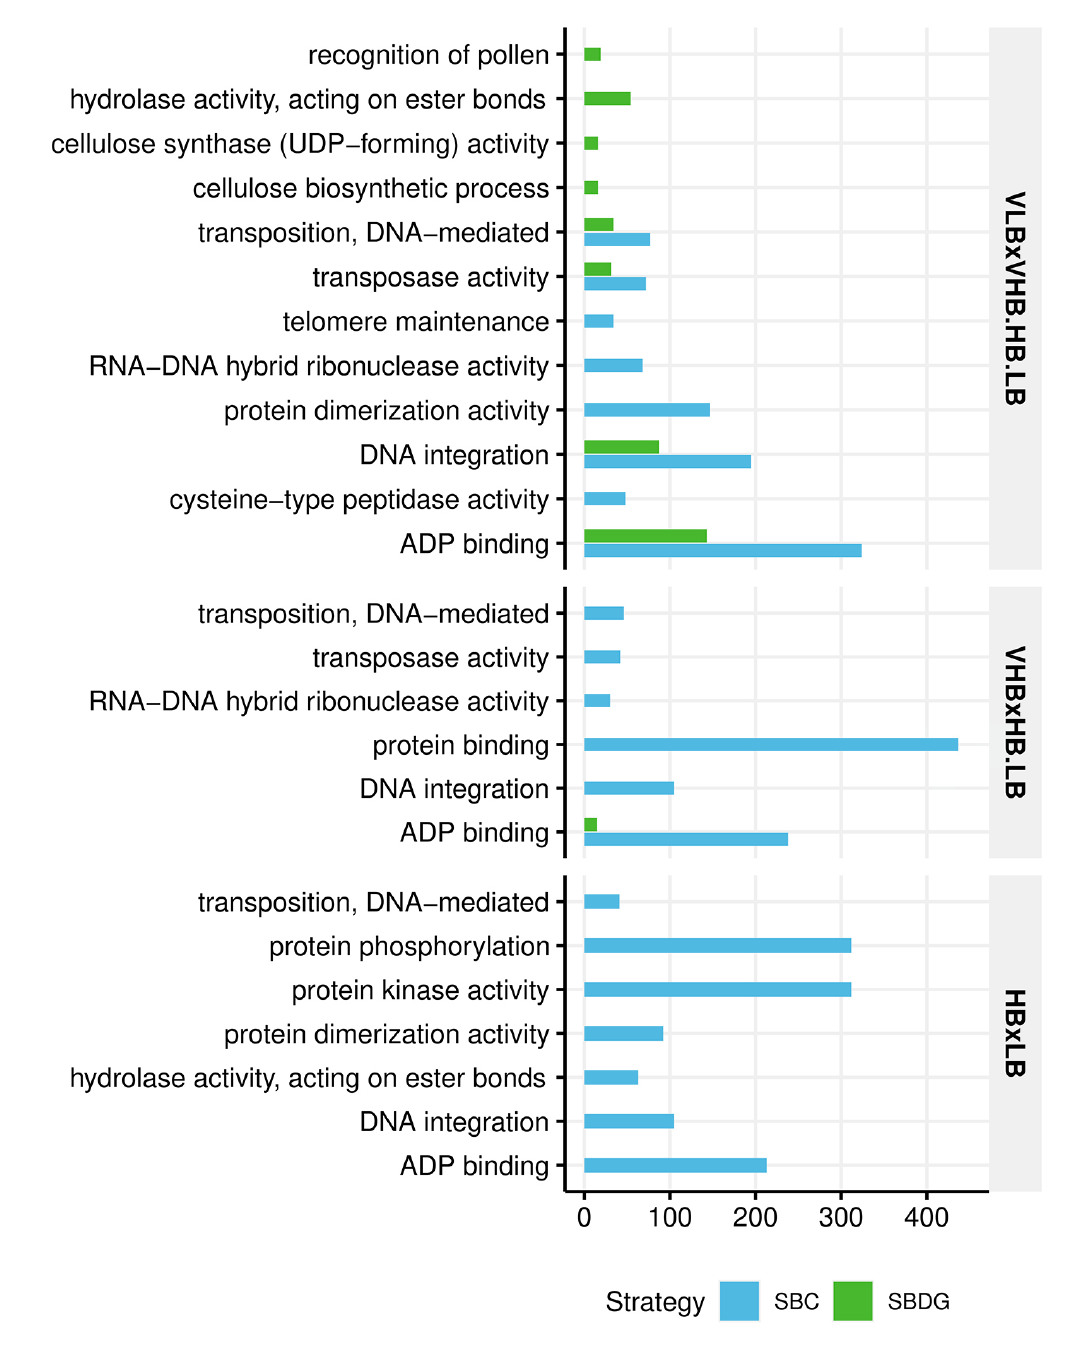
Figure 2 – Enriched gene ontology terms by strategy and contrast. There was no significant test result for HB × LB in the strategy based on diverse genotypes (p < 0.01, after FDR adjustment). The numeric axis represents the number of differentially expressed genes for each particular gene ontology